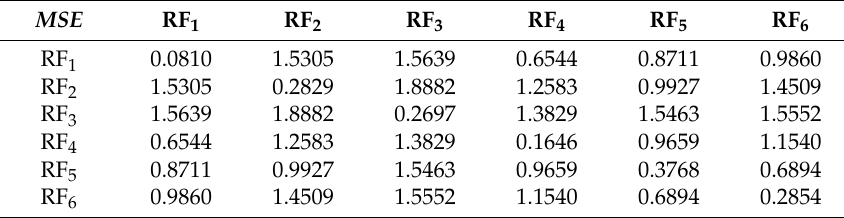
Table 5. The average Euler distance based on ( f 2 , f 6 , f 19 , f 32 , f 95